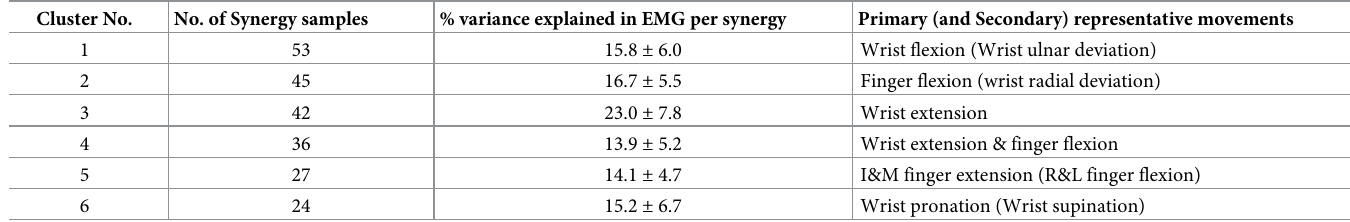
Table 3. Characteristics of clusters computed from the synergy pool of 40 able-bodied subjects. Cluster No.